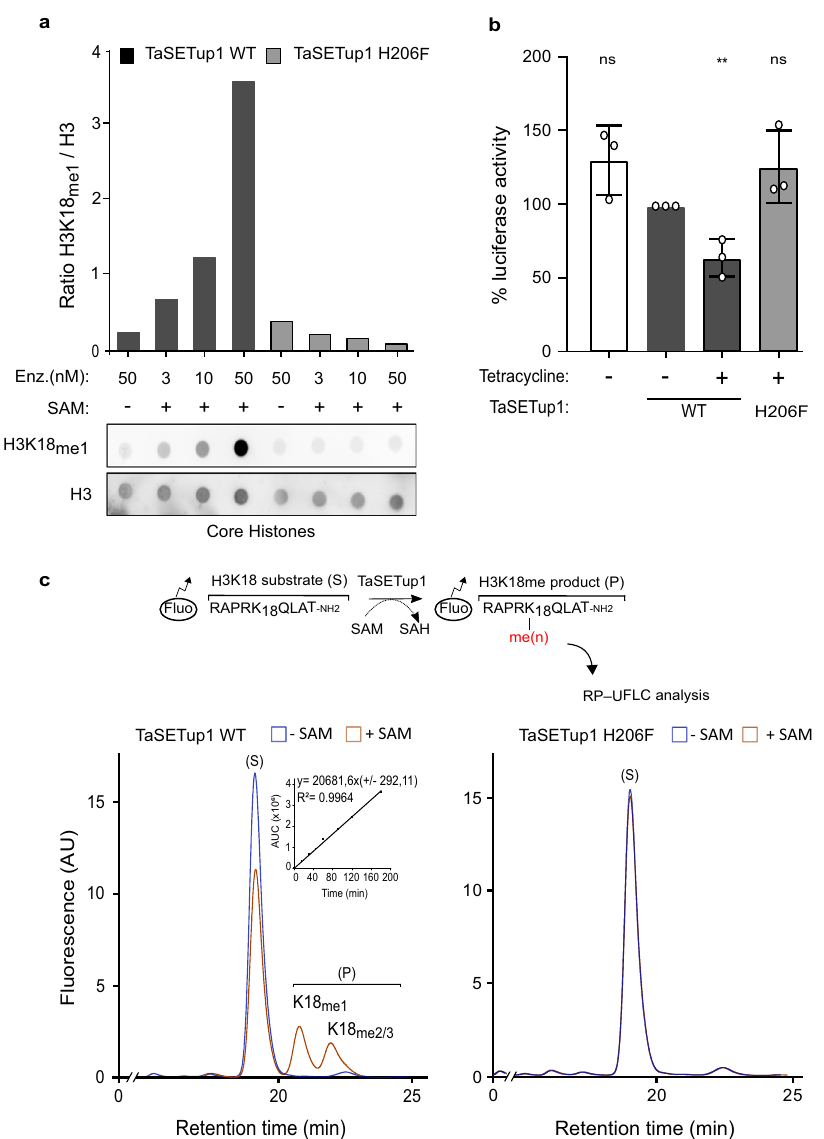
Fig. 7 The Theileria TaSETup1 can methylate H3K18 and repress gene expression. a Methyltransferase assay of recombinant TaSETup1 (wild-type WT or mutant H206F) incubated with or without SAM and core histones followed by immuno-dot-blot detection with H3K18me1 antibody. The quanti fi cation results were normalized to H3. This result is representative of three independent experiments showing similar outcomes. b Assay of TaSETup1 methyltransferase activity by quanti fi cation of fl uorescent H3K18 peptide (substrate S and methylated product P). Chromatograms show mono-methylated (K18me1) and di/tri methylated (K18me2/3) product in presence or absence of SAM for WT and mutant enzymes. Inset: Integration of the peak (AUC area under the curve). c Recruitment of GAL4-TaSetup1 (but not the GAL-TaSETip1 H206F mutant) caused repression of the Luciferase transgene in T-Rex cells in the presence Tetracycline (48 h). The % Luciferase activity represents the mean of n = 3 biologically independent experiments. Error bars represents mean values ± Merogony induction . Macroschizont-infected TaC12 cells were induced to dif- infected with T. parva . Cells were cultured in RPMI 1640 (Gibco-BRL), supple- ferentiate to merogony by increasing the culture temperature to 41 °C 32 . Cells were mented with 10% heat-inactivated foetal bovine serum (FBS), 4mM L -glutamine, 25mM HEPES, 10mM β -mercaptoethanol and 100 mg/ml of penicillin/strepto- passaged each time they reached con fl uence and 2× 10 6 cells collected at day 0 mycin in a humidi fi ed 5% CO 2 atmosphere at 37 °C. HEK 293T-RexLuc cells were (macroschizont stage) and day 8 (merogony stage) for RNA extraction and 4 ×10 3 grown in DMEM supplemented with 10% FBS and 100 mg/ml of penicillin/ cells per immuno fl uorescence at the same time-points. streptomycin in a humidi fi ed 5% CO 2 atmosphere at 37°C. The anti-parasite drug Buparvaquone (BW720c) was used at 50ng/ml for 48 h (Chemos GmbH, ref: 88426-33-9). The KDM inhibitor (KDMi) is the well-characterized, broad- spectrum lysine demethylase inhibitor tranylcypromine (TCP) (a generous gift from A. Mai, Sapienza University, Rome) used at 1µM, 48H and the KDAC inhibitor (KDACi) 24h at 40 nM (compound FR235222, a generous gift from MA. Hakimi). The KDM inhibitor (KDMi) is used at 1µM, 48 h and the KDAC inhi- bitor (KDACi) 24 h at 40 nM (compound fr235222 from MA. Hakimi, IAB, Gre- Slides were blocked with PBS 0.2% Tween (PBST) – 1% BSA for 30 min. Primary noble, France).